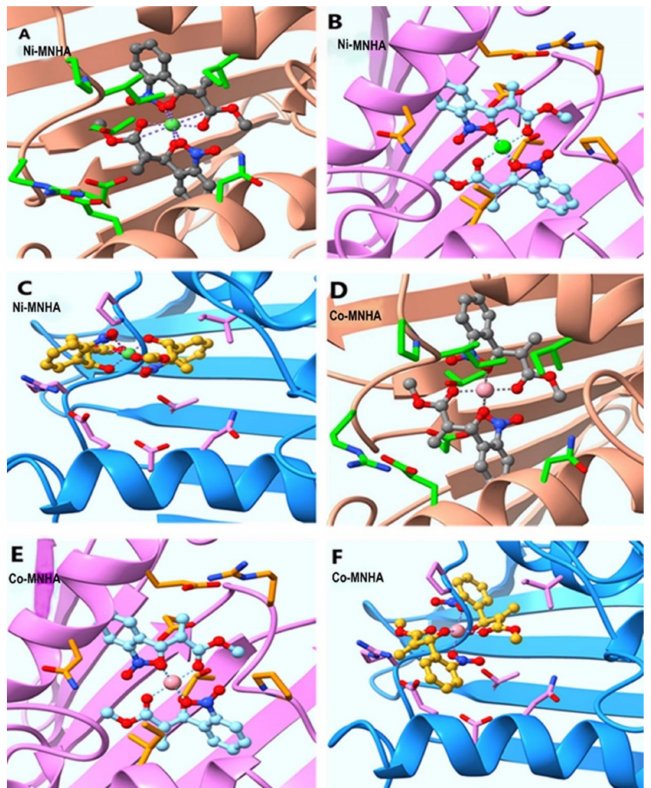
Figure 11. The binding conformations of ligand (MNHA) metal complexes against ( A , D ) E. coli , ( B , E ) S. typhi , and ( C , F ) S. aureaus